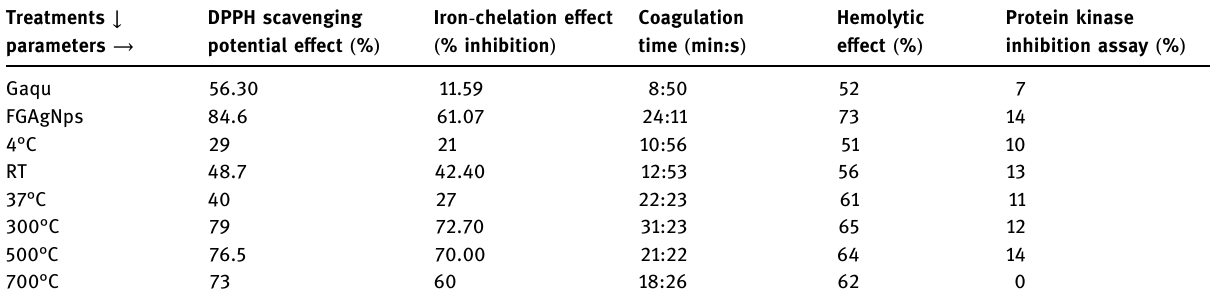
Table 2: In vitro biological activity of green - synthesized silver nanoparticles ( GAgNPs ) and the extract of Allium sativum ( Gaqu )